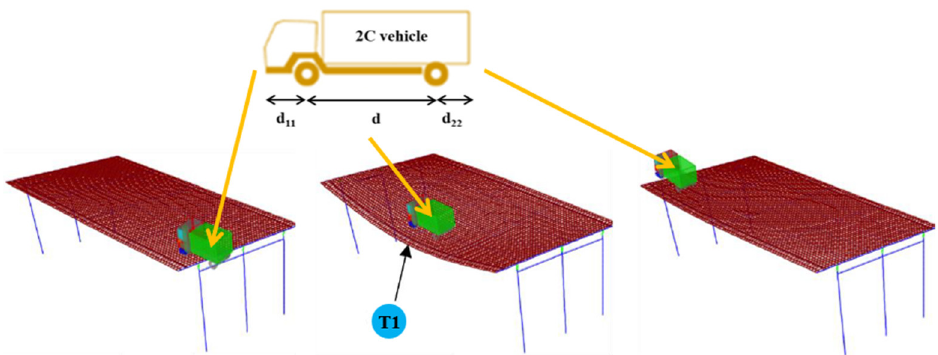
Figure 6. Dynamic simulation of the bridge–vehicle interactions by FEM [60] and configuration of the used two-axle 2C vehicle type (adapted from [56]).